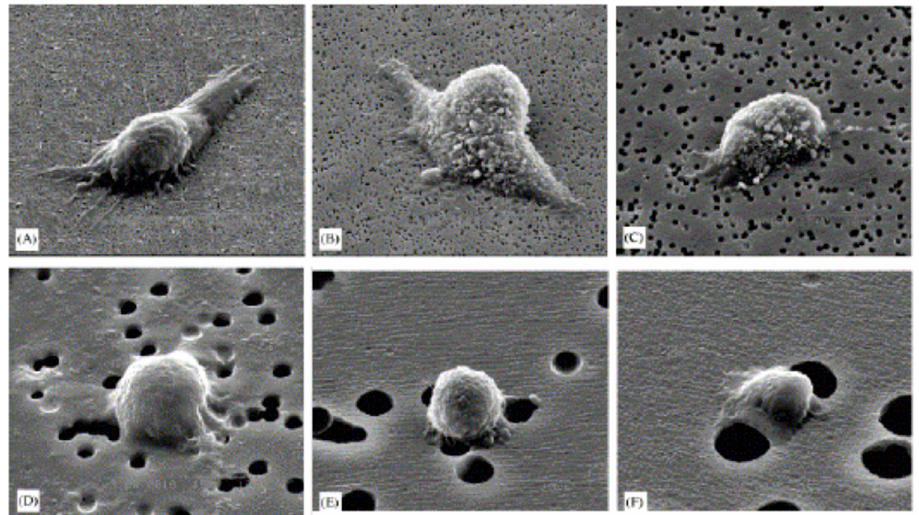
Figure 3. Scanning elelctron microscopy images of MG63 cells attached on the polycarbonate (PC) membrane surfaces with micropore sizes ranging from 0.2 ( A ), 0.4 ( B ) 1 ( C ), 3 ( D ), 5 ( E ), and 8 mm ( F ). Reprinted from reference [60] with permission from Elsevier.